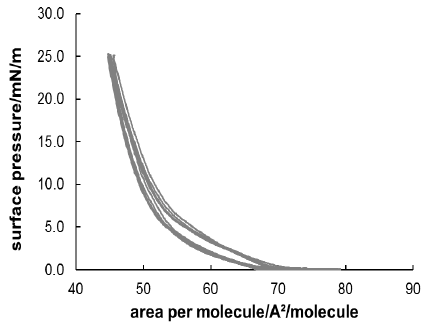
Figure A2. Isothermic compression and expansion hysteresis at 25 °C with 3% polymer content.